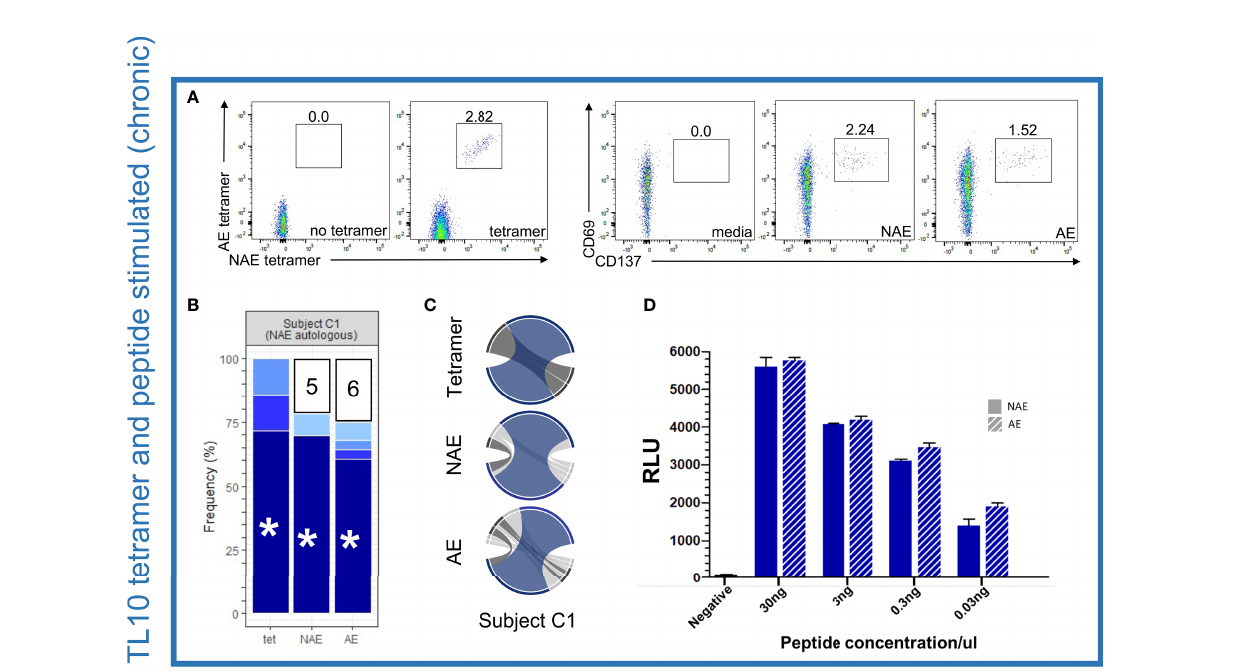
FIGURE 2 | Dominant TCR a / b combinations for TL10-speci fi c CD8 + T cells are cross-reactive for the NAE and AE form but show no difference in antigen-speci fi c reactivity or sensitivity to the different forms of the HLA-peptide complex. (A) Flow cytometry plots for NAE- and AE-speci fi c CD8 + T cells indicate a cross-reactive population using HLA class I tetramers and similar proportions following peptide stimulation for subject C1 for the epitope TL10 (negative controls included). (B) Common TCR CDR3 a / b combinations were observed in all three conditions with the remaining combinations unique to each condition grouped with the number of combinations listed (each color represents a single CDR3 combination). (C) Circos plots depict the TCR a / b CDR3 combinations observed in each condition with the CDR3 combination tested in panel D colored to match those depicted in panel B (highlighted with an asterisk). Note the circus plot shows the a and b chain of the highlighted combination are rarely observed with other alternate chains. The remaining TCR a / b CDR3 combinations common to all conditions are highlighted in dark grey. b chains are depicted on the bottom, with a chains depicted on the top. The width of each band correlates with the frequency of the respective a / b combination. (D) There was no difference in antigen-speci fi c reactivity observed in the peptide dilution series (duplicates) of a common dominant TCR a / b CDR3 combination in subject C1 (indicated with an asterisk in panel B) for the NAE and AE form of TL10 using a T cell reporter assay. The negative control is transfected Jurkat cells with antigen presenting cells minus peptide. RLU = relative light units. N =